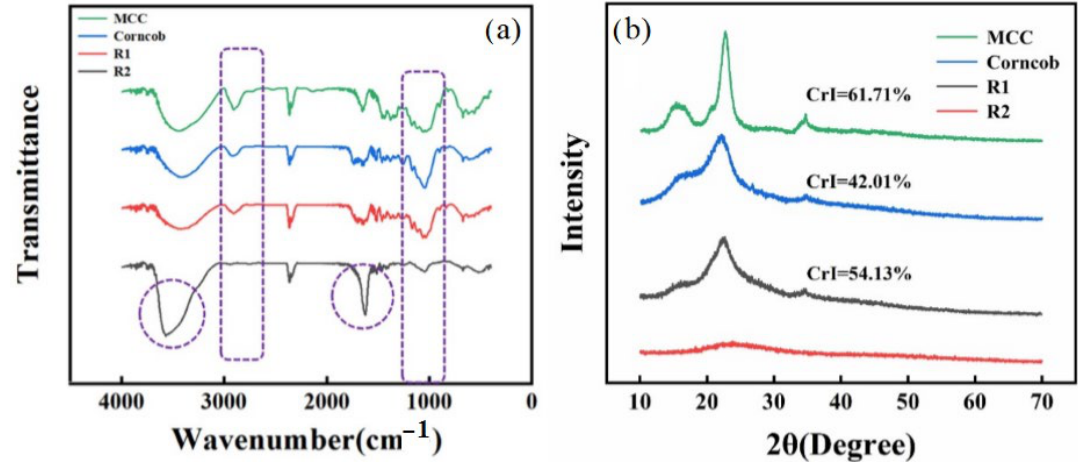
Figure 6. ( a ) FTIR and ( b ) XRD spectra of MCC, corncob, R1, and R2.